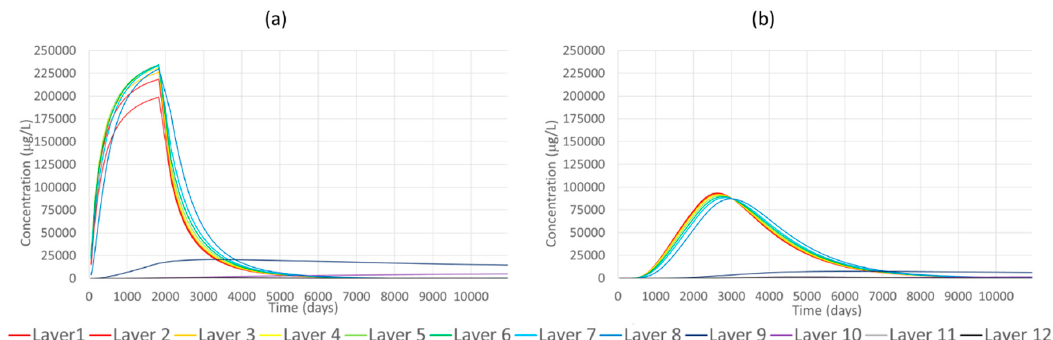
Figure 9. Concentration distributions of models A1 and A2 at the end of the simulations (205 years) in observation wells called OBS1 ( a ) and OBS3 ( b ).